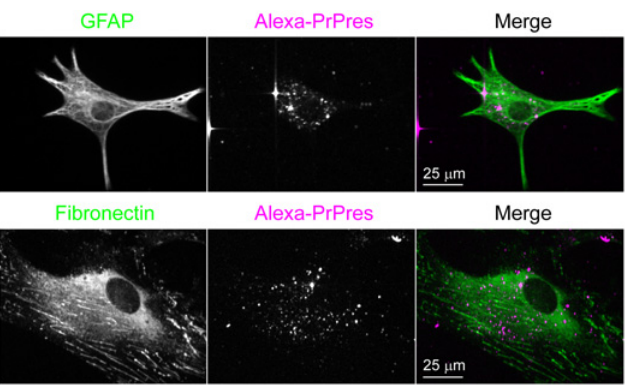
Fig 7. PrPres-positive non-neuronal cells present in neuron-enriched cultures are astrocytes and fibroblasts. Neuron-enriched culture was treated for 5 d with 263K A647 followed by immunostaining for astrocytes (GFAP) or fibroblasts (Fibronectin). Images correspond to single 0.5 μ m optical Z slices.